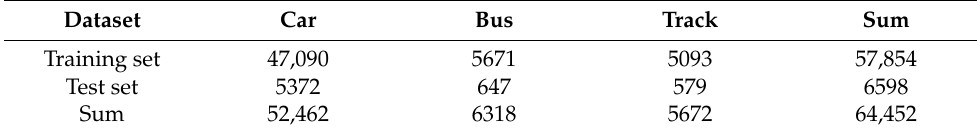
Table 3. Statistical result of the three vehicles in the training and test